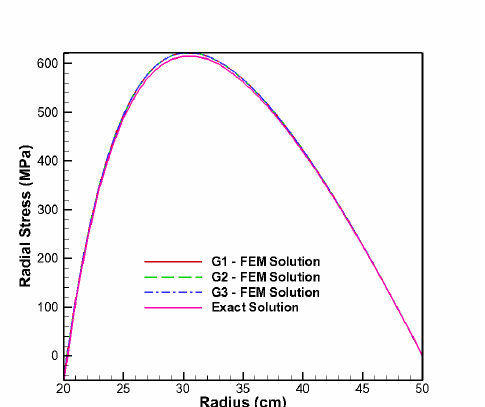
Figure 4. Tangential stress under linearly increasing thermal profile, q = 50 MPa, T i T = 0 o C , T = 500 o C and ω = 350 ref r o